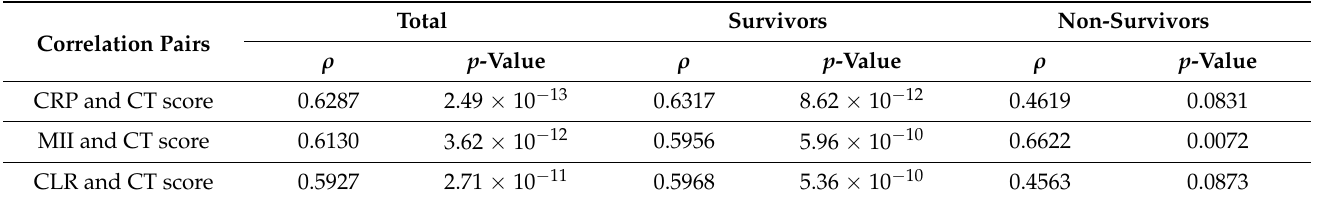
Table 2. Correlations of CRP and CRP-derived inflammatory indices with CT score on the day of admission.